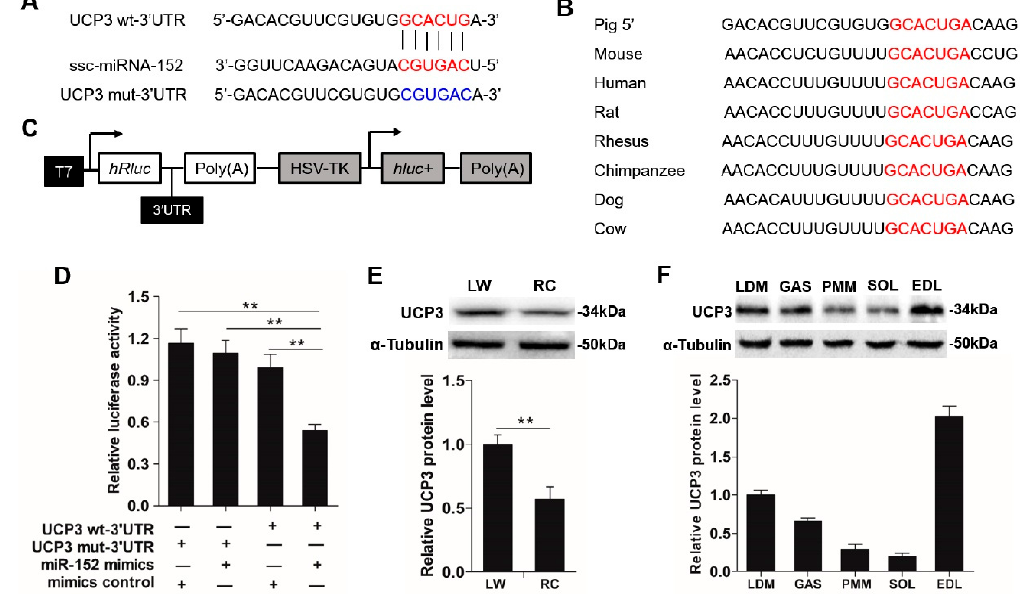
Figure 4. UCP3 is a target of miR-152. ( A ) Schematic illustration of the predicted binding site for miR-152 in UCP3 3’UTR. The wild-type miRNA-binding sites in UCP3 3’UTR (red) were modified to complementary sequences (blue) to construct the mutated UCP3 3’UTR. ( B ) The predicted binding site of miR-152 in UCP3 3’UTR is highly conserved among mammals. ( C ) The sketch map of the dual-luciferase reporter vector psi-CHECK2. The putative miR-152 target site of UCP3 3’UTR and mutation target site were inserted into the psi-CHECK2 vector at the 3’ end of the Renilla luciferase gene ( hRluc ). The Firefly luciferase activity was treated as an internal normalization control. ( D ) The luciferase reporter containing the wild type and mutant UCP3 3’UTR was co-transfected into HEK293T cells with miR-152 mimics or mimics control. At 48 h post-transfection, the Renillas luciferase activity was measured and normalized to the firefly luciferase activity. ( E ) UCP3 protein expression in the LD muscles of LW and RC pigs ( n = 5, five pigs), α -Tubulin served as the reference. ( F ) UCP3 protein expression in di ff erent types of skeletal muscle in adult LW pigs (n = 5, five pigs), α -Tubulin served as the reference. Results are presented as mean ± S.E.M. ( n = 4, four independent experiments). * p < 0.05, ** p < 0.01 and *** p < 0.001 as contrasted with the